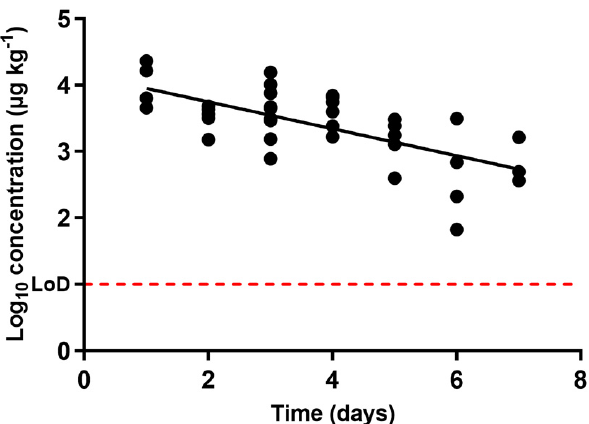
Figure 3. Occurrence of the concentration of enrofloxacin in urine samples obtained from pigs treated with enrofloxacin at pre-set intervals within the withdrawal period (when day 0 matches the end of the treatment), determined via liquid chromatography with tandem mass spectrometry (LC-MS/MS). The LoD dotted line represents the detection limit of the analytical technique for en- rofloxacin.